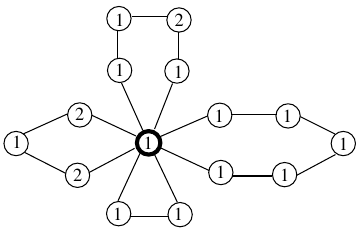
Figure 10: A zonal labeling of an irregular Dutch windmill plane graph.